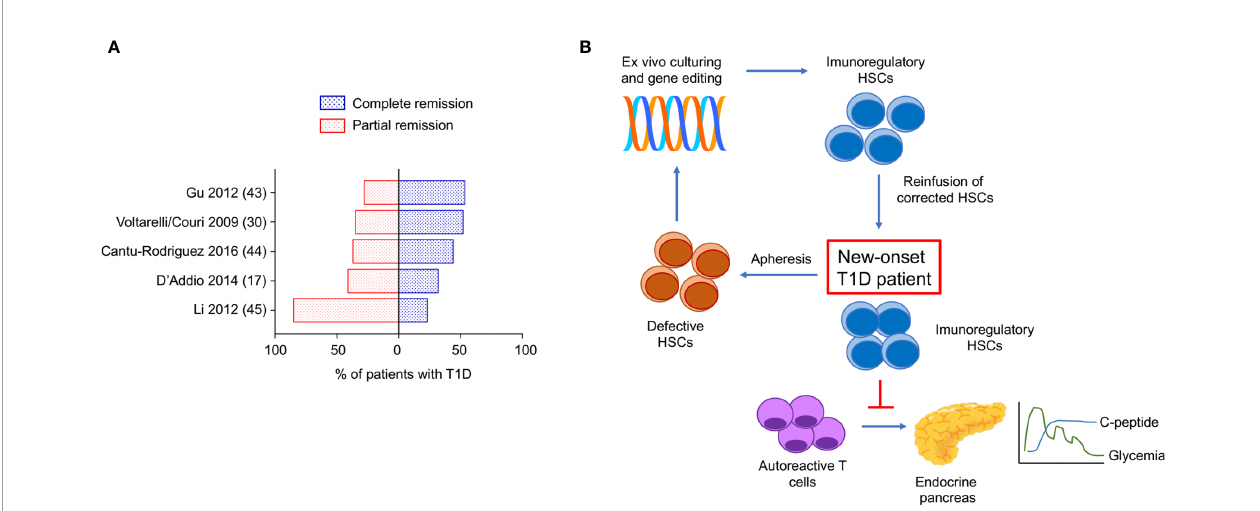
FIGURE 1 | Complete/partial remission of type 1 diabetes obtained with AHSCT in the long-term. Proposed genetic engineered HSC-based approach to target type 1 diabetes. (A) Proportion of patients with T1D undergoing AHSCT who achieved complete remission (insulin independence) and partial remission (low dose exogenous insulin requirement) at the latest timepoint analyzed within each clinical study registered in ClinicalTrials.gov available as publication. (B) Use of genetically engineered HSCs to target T1D: proposed approach. T1D, type 1 diabetes; AHSCT, autologous hematopoietic stem cell